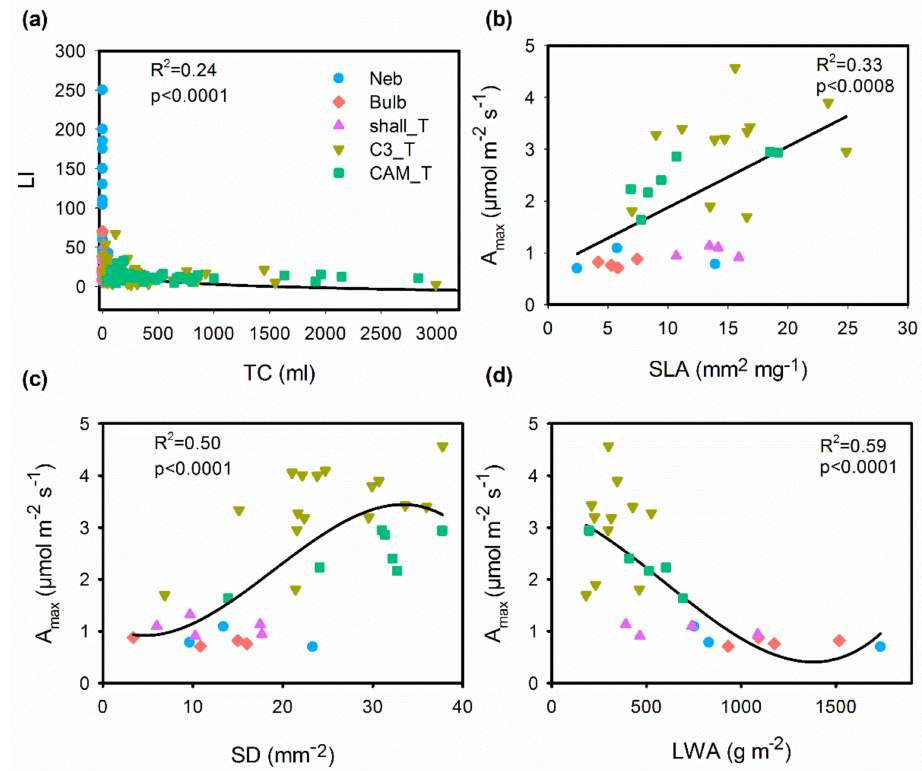
Figure 5. Significant relationships of functional trait across the five functional groups of epiphytic Bromeliaceae; ( a ) leaf index (LI) versus tank capacity (TC); ( b ) light saturated photosynthetic rate per leaf area (A max ) versus specific leaf area (SLA); ( c ) A max versus stomatal density (SD); ( d ) A max versus leaf water content on area basis (LWA). Each point corresponds to the mean value per species. Point colors correspond to the following functional groups: Bulb = pseudobulbs (pink); C3_T = C 3 tanks (yellow); Shall_T = shallow tanks (purple); CAM_T = CAM tanks (green); Neb = nebulophytes